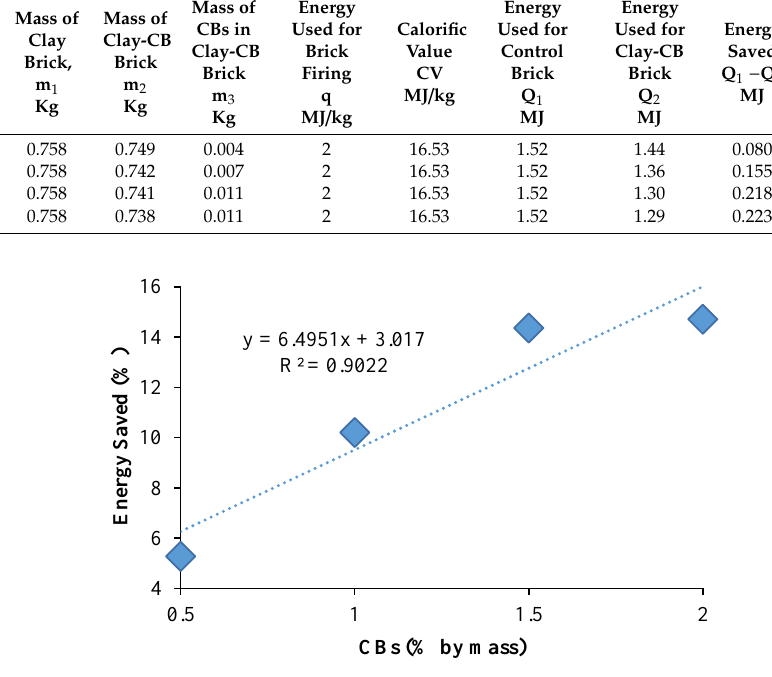
Figure 16. Energy saving versus CB percentage by mass.